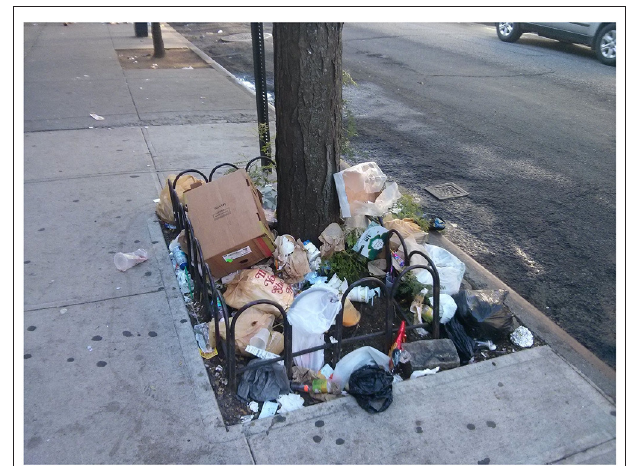
FIGURE 4 | An example of a trophic subsidy from the gray habitats of Manhattan into a green habitat. Here one sees a small “green” habitat in the form of a tree in a tree pit in New York City. In this scene, the organisms living in the gray habitat around the tree–such as pavement ants–are subsidized both by the carbon produced by the tree and the plants growing around the tree and by the human garbage mounded around the tree. Photo by Jason Munshi-South,